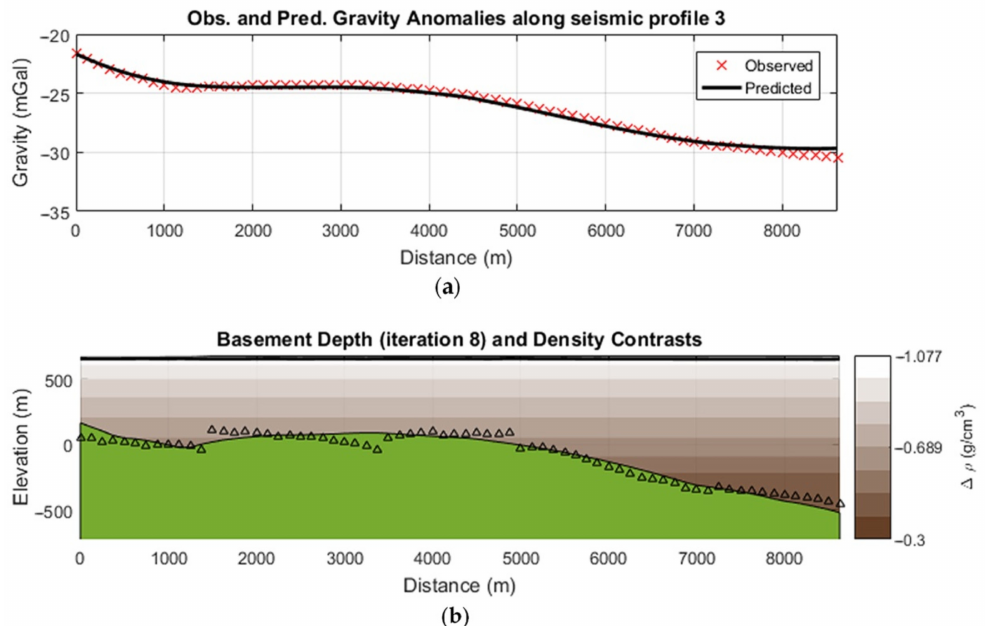
Figure 11. Comparison of the depth to the seismic reflector interpreted as the top of the carbonatic rocks, and the gravity basement along the seismic profile 3 (see Figure 2). ( a ) Observed and model- predicted gravity; ( b ) gravity basement (green) and seismic reflector (triangles). Brown shading represents the density contrast variation with depth estimated in the ITRESC